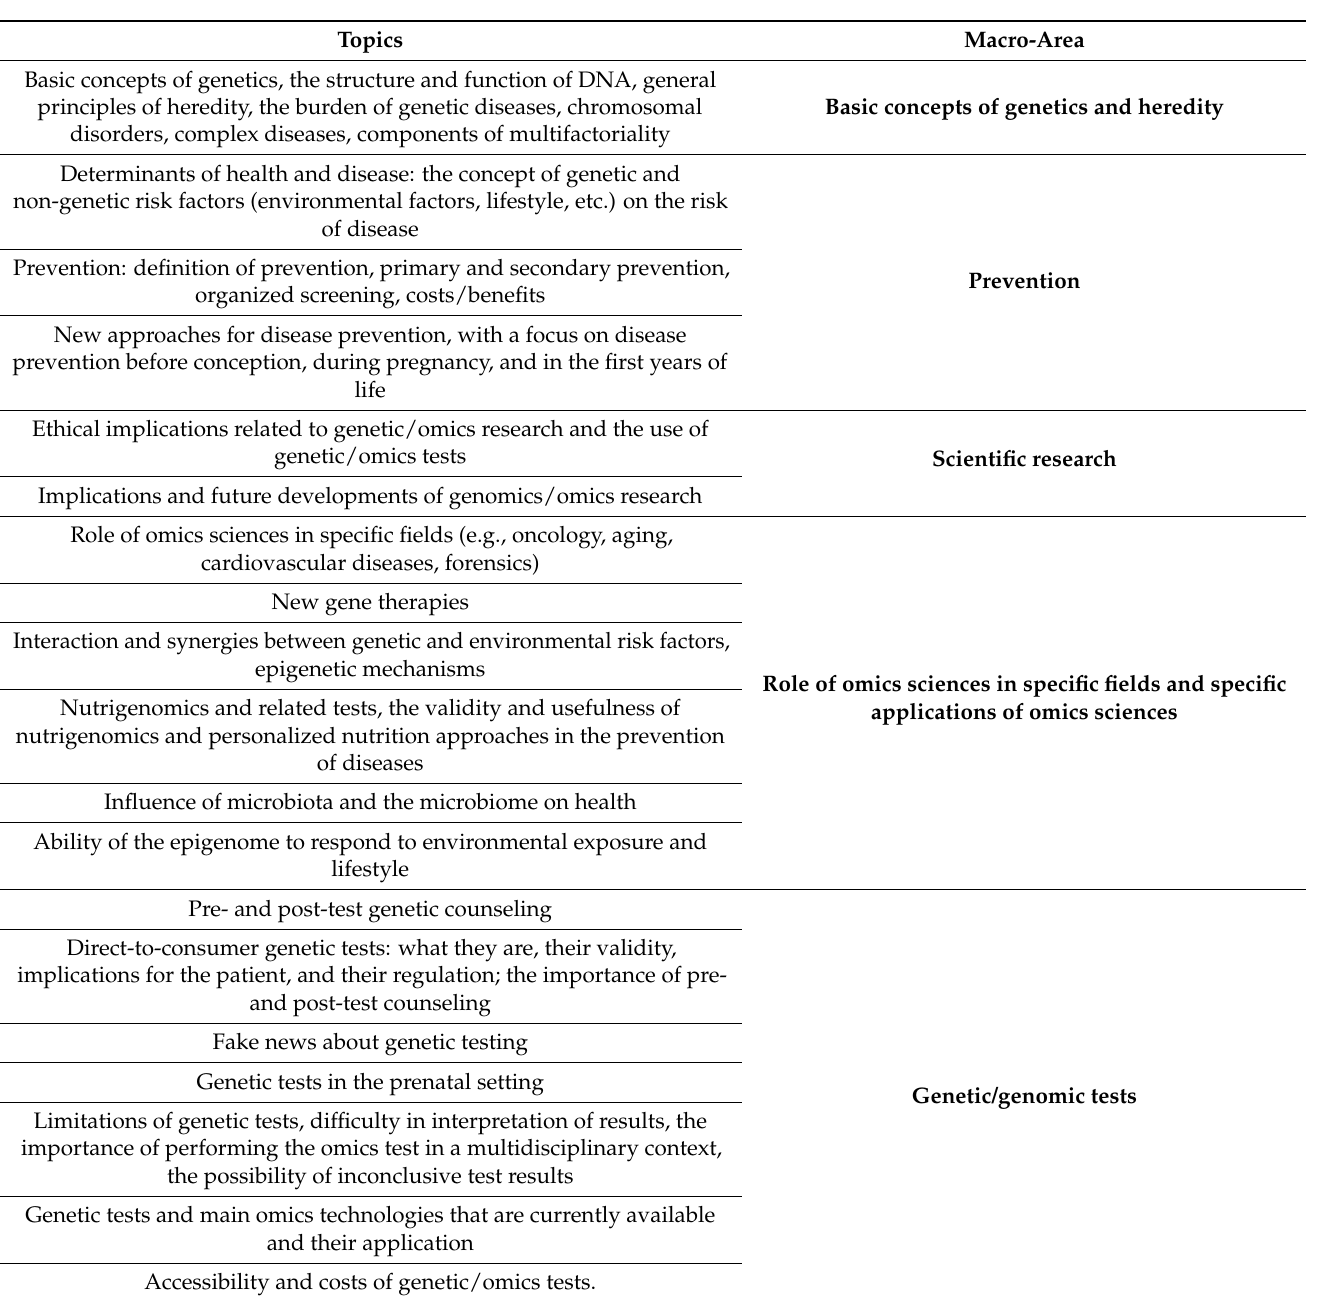
Table 3. Items selected in the category “Topics to address in citizens’ educational initiatives”, accord- ing to macro-area (within each macro-area, items are listed by decreasing mean